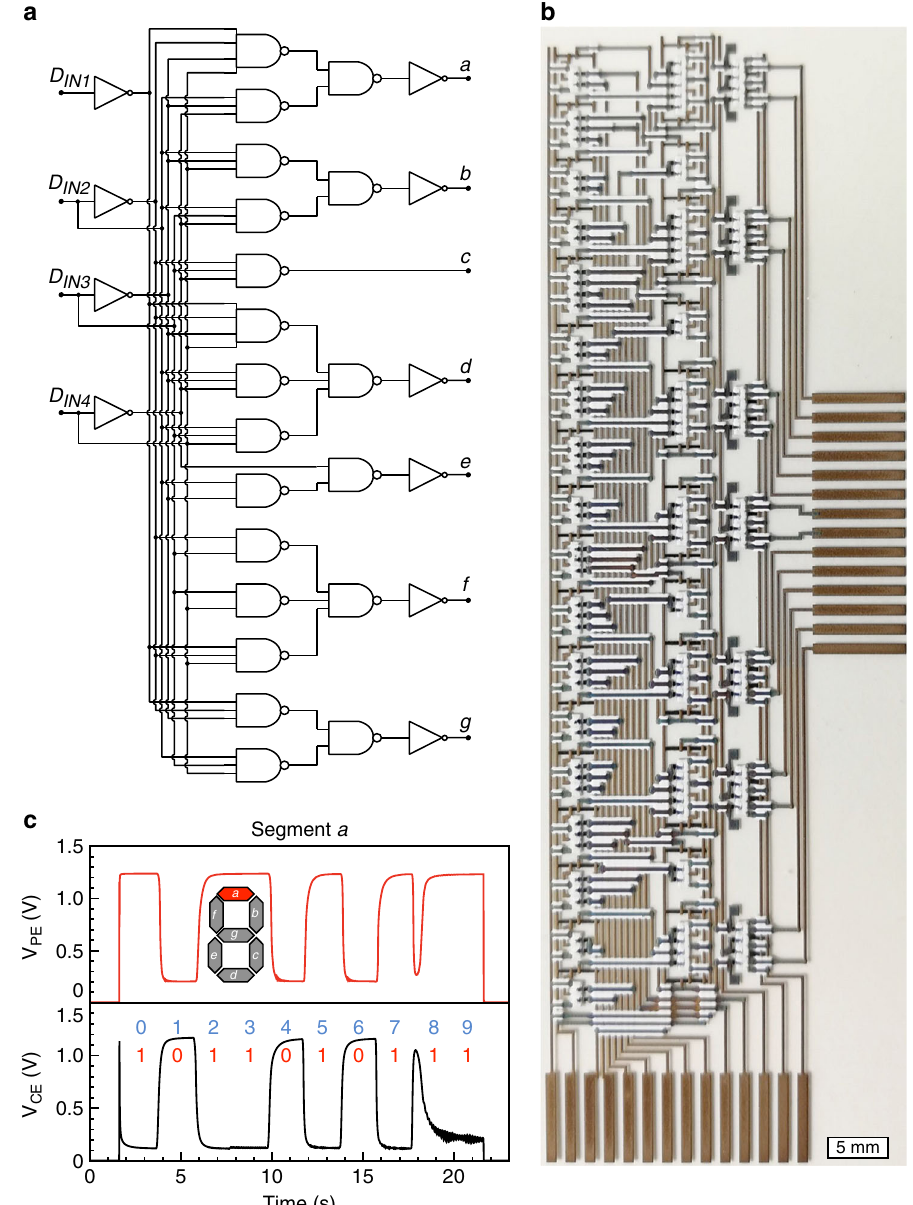
Fig. 4 Binary-coded decimal 4-to-7 decoder. a Schematics of a 4-to-7 decoder implemented with inverters and NAND gates, including two-, three-, and four-input NAND gates. b Photograph of the all-printed decoder that consists of 87 PEDOT:PSS-based OECTs (scale bar: 5 mm). Note that the details of the seven rightmost sub-circuits, representing the display driver circuitry including 28 additional OECTs, are omitted in this discussion. Four of the 14 pads located in the lower part of the image are input signals (D IN1 , D IN2 , D IN3 , D IN4 ), whereas the other pads are dedicated to V DD , V SS , two GND pads, pixel voltage, enable signal, and four pads for testing. Each display segment (a, b, c, d, e, f, g) consists of one pixel electrode and one counter electrode, which results in seven pairs of output pads located on the right side of the image. These output pads are used for circuit characterization, or to connect the circuit with an external display device. c Logic voltage output sequence (V PE , data shown in red are the logic level controlling the display pixel electrode) of segment a [1,0,1,1,0,1,0,1,1,1] when the input signal corresponds to the digits [0,1,2,3,4,5,6,7,8,9]. The data shown in black are the logic voltage level controlling the display counter electrode (V CE ), hence, the two data sets are inverse to each other. The input signal representing the counting